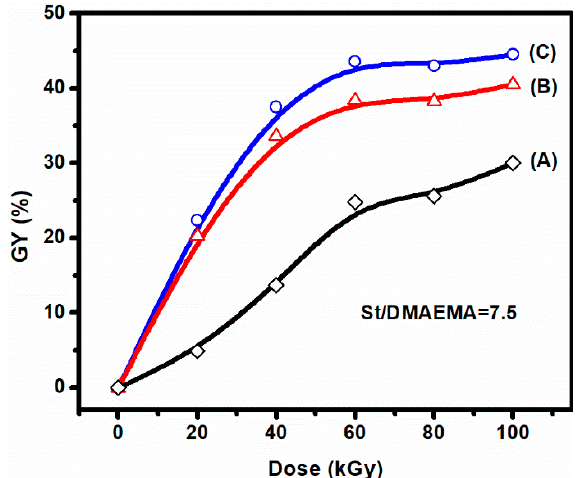
Figure 2. Effect of absorbed dose on the grafting yield (GY) of monomers of styrene (St) and dimethylaminoethyl methacrylate (DMAEMA) dispersed in green solvent water with a small amount of polyoxyethylene sorbitan monolaurate (Tween-20) as an emulsifier grafted onto poly(vinylidene difluoride) (PVDF) powder (referred to as PVDF- g -P(St- co -DMAEMA)) with a weight ratio of DMAEMA to St of 0.13 in ( A ) 0.60, ( B ) 0.75, and ( C ) 0.90 M emulsions, respectively.